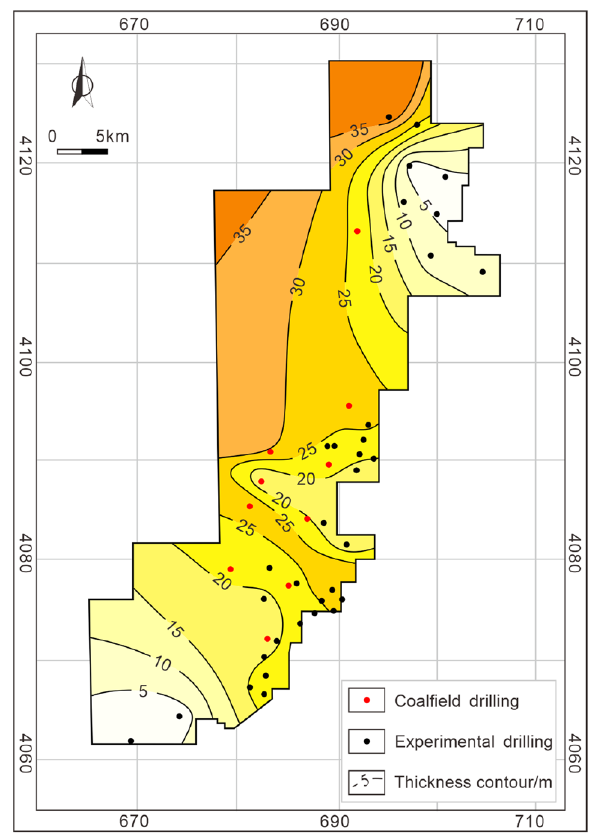
Figure 6. Cumulative thickness contour of sandstone in the Taiyuan